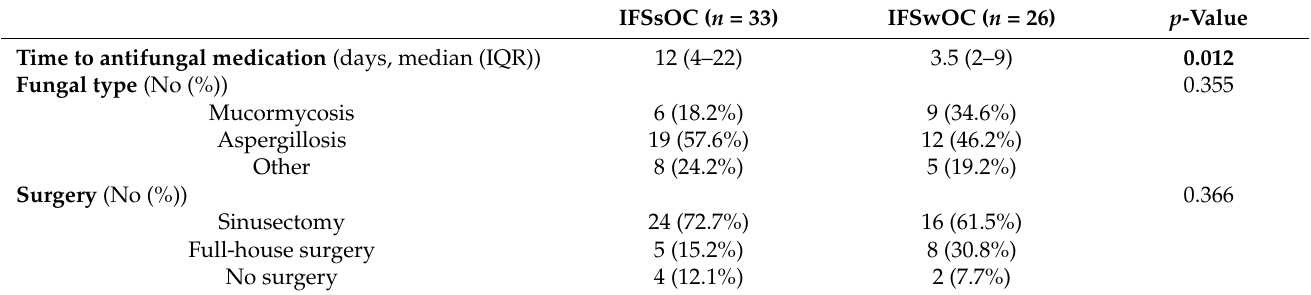
Table 4. Comparison of the fungal type and surgery between the IFSsOC group and IFSwOC